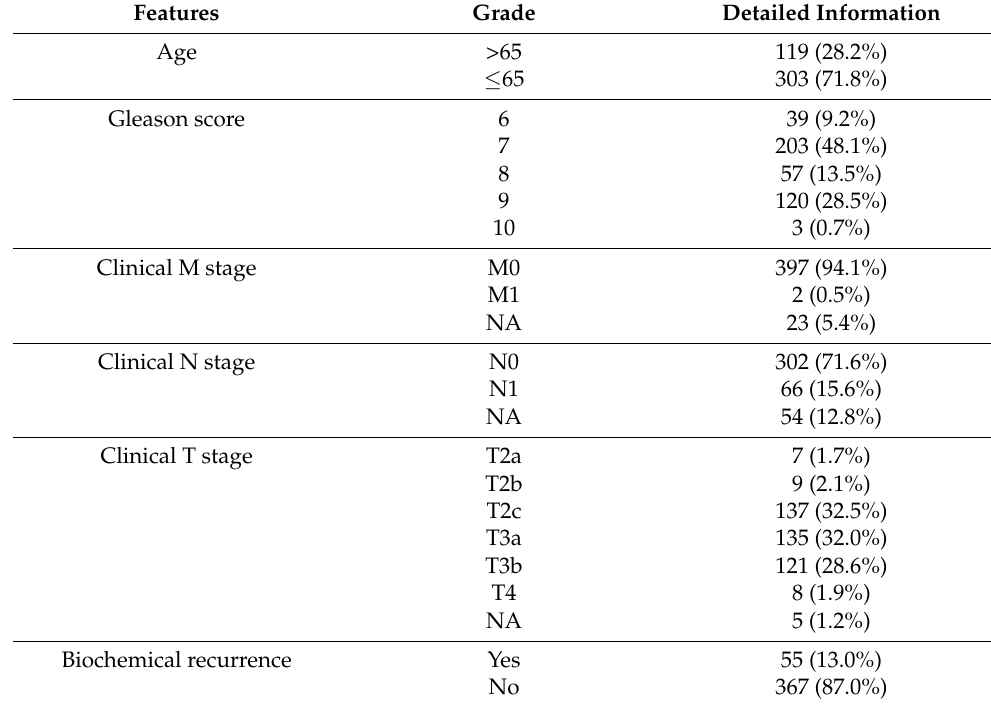
Table 1. Relevant clinical information of 422 PCa